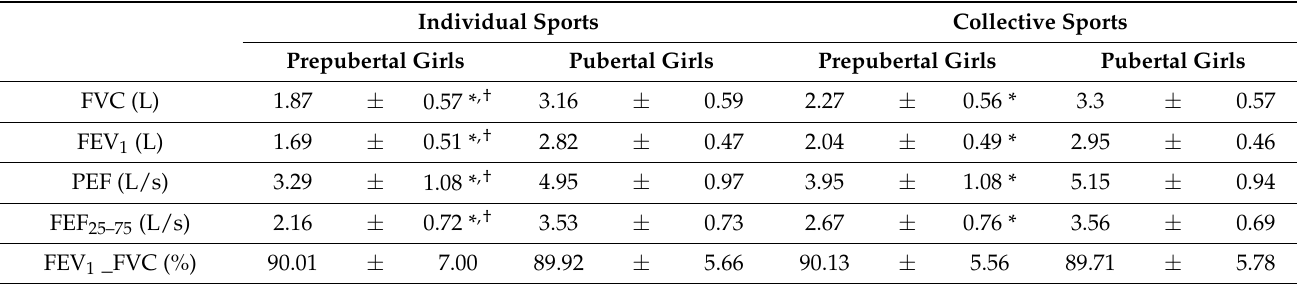
Table 2. Respiratory Variables According to the Typology of Sport in Prepubertal and Pubertal